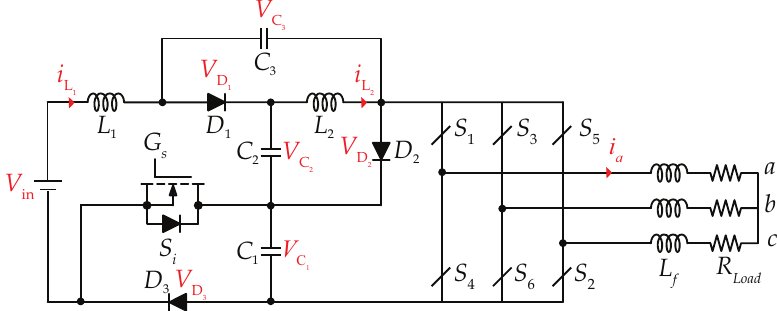
Figure 4. Schematic of the proposed switched-quasi-Z-source